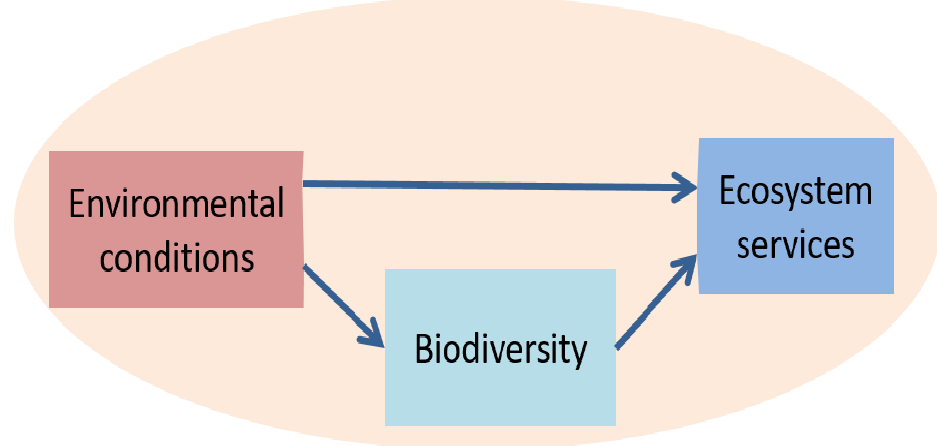
Figure 1. Direct and indirect relationships between environment (climate, soil, management), biodiversity and ecosystem services. Biodiversity supports and modulates the ecosystem services that can be provided under given environmental conditions.